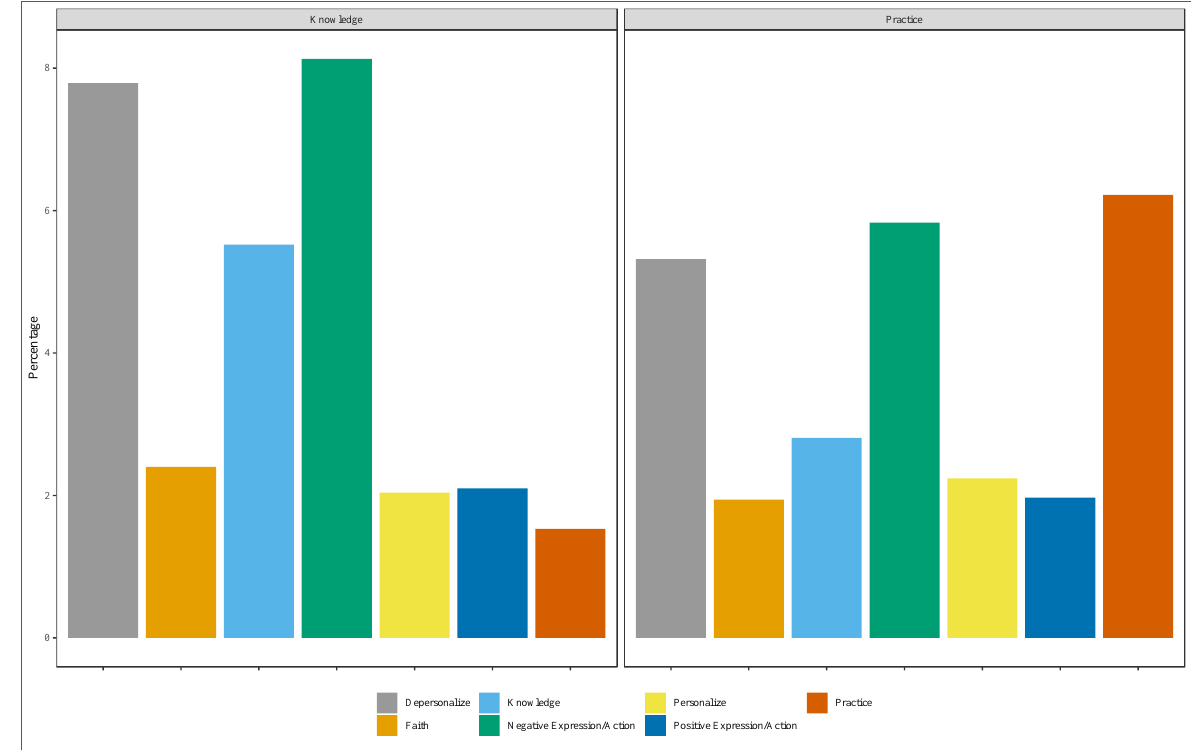
Figure 1. The word percentages of the seven sub-categories in the corpora.